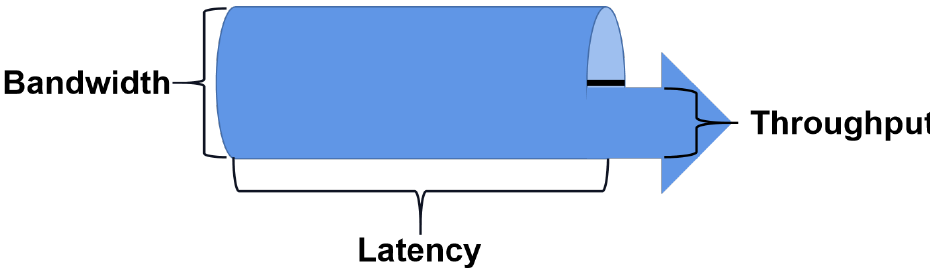
Figure 2. Throughput, bandwidth, and delay.